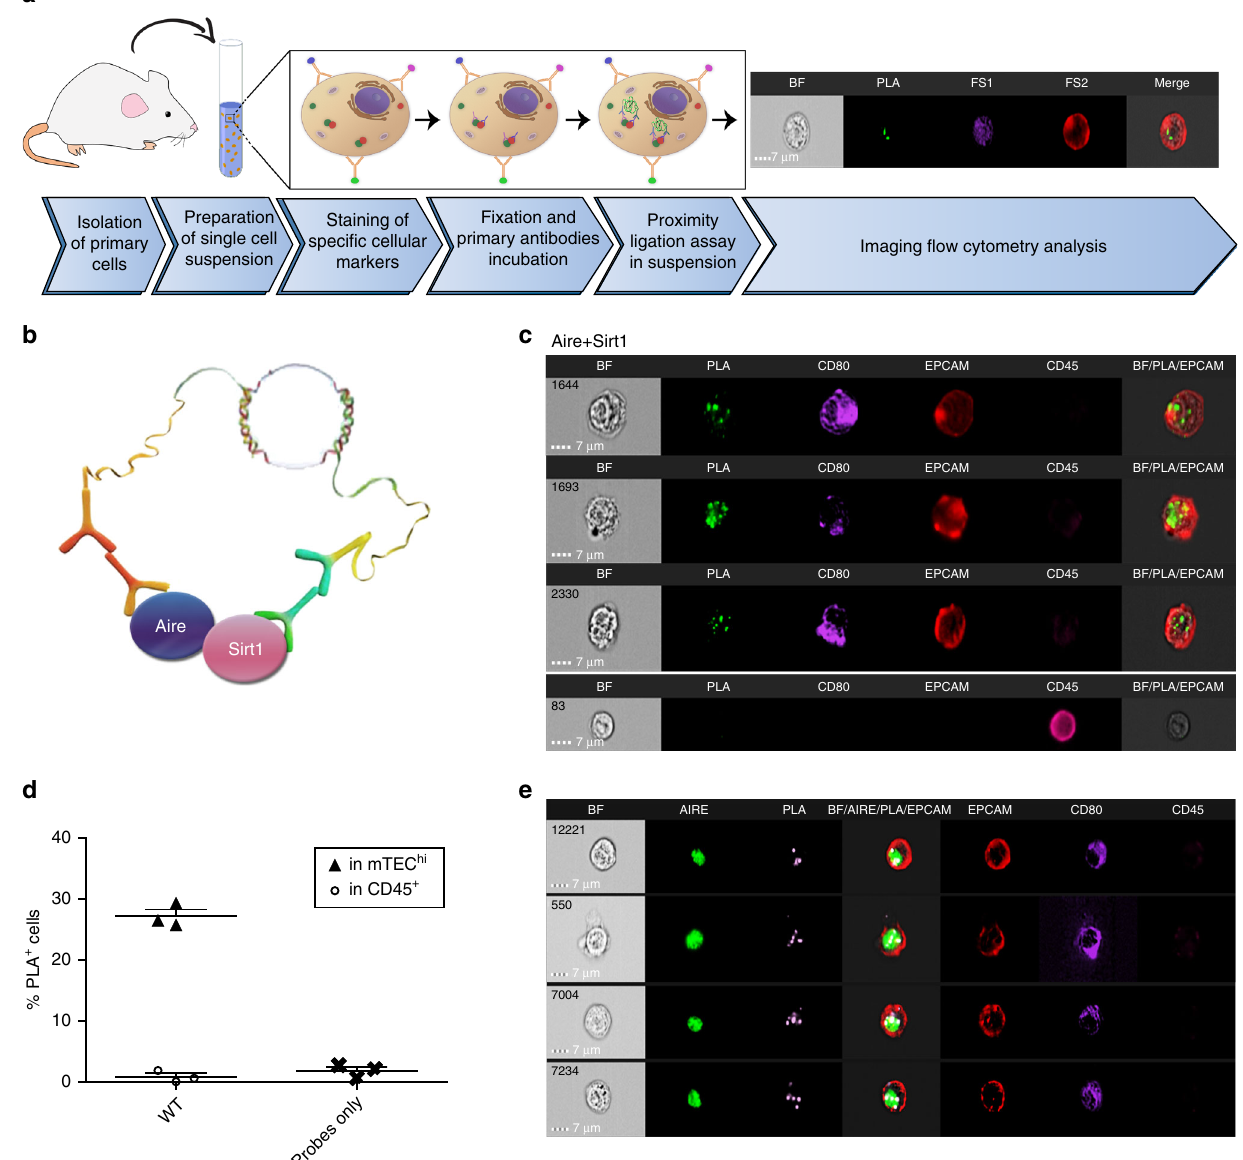
Fig. 1 Detection and quanti fi cation of PPIs at a single cell level by PLIC. a A graphical scheme illustrating the main steps of the PLIC protocol. FS fl uorescent signal. b A graphical scheme illustrating PLIC analysis of Aire and Sirt1 interaction. c PLIC analysis showing representative images obtained from imaging fl ow cytometry of the interaction of Aire and Sirt1 in mTEC hi and CD45 + populations presented as (left to right): bright fi eld (BF), PLA signal (green), staining of CD80 (PB), EpCAM (APC), CD45 (APC/Cy7), and BF/PLA/EpCAM overlay (merged). d Quantitative analysis of Aire and Sirt1 interaction (data are presented as percentage of positive cells (PLA + ) in mTEC hi or CD45 + cells isolated from WT mice, compared to probes background. Shown are values from three independent experiments. Each point on the graph (triangle for mTEC hi , circle for CD45 + , and cross for probes only) represents an averaged value of single independent experiment, calculated from 2 to 4 biological replicates, +s.e.m). e PLIC analysis showing representative images of the interaction of Aire and Sirt1 in mTEC hi overlaid with Aire staining (left to right): bright fi eld (BF), Aire-AF488 (5H12), PLA signal (FarRed), BF/Aire/PLA/ EpCAM overlay (merged), staining of EpCAM (APC/Cy7), CD80 (PB), and CD45 (PE/Cy7). Scale bar 7 μ